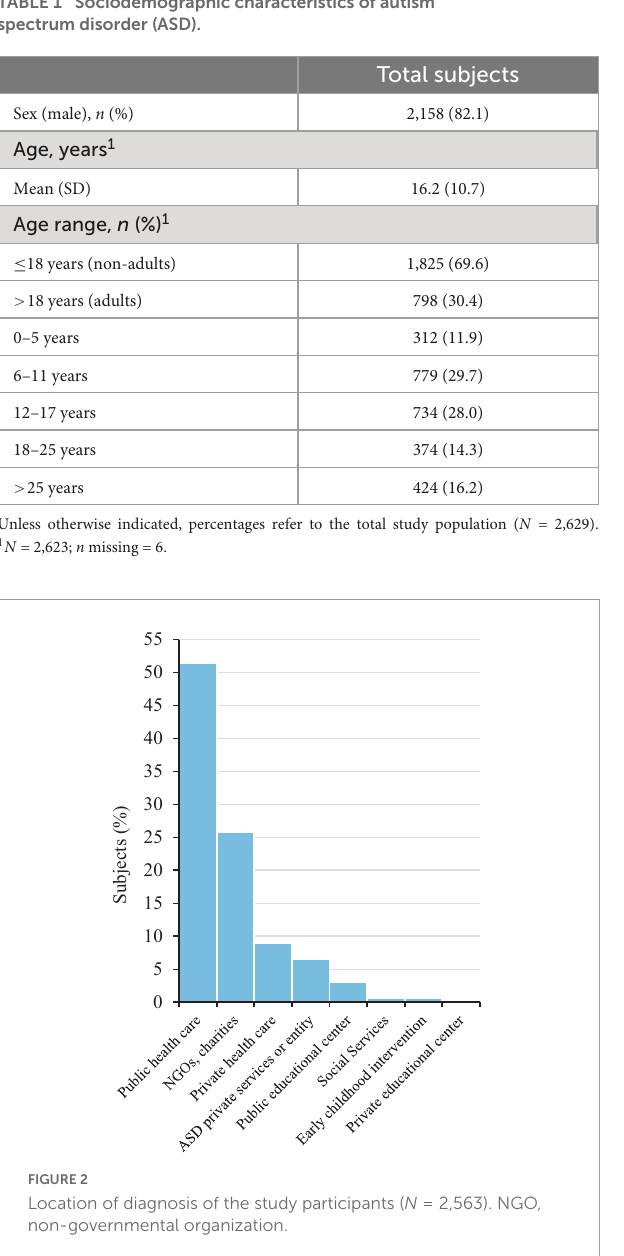
significantly higher for women than for men (18.4; SD = 12.1 vs.